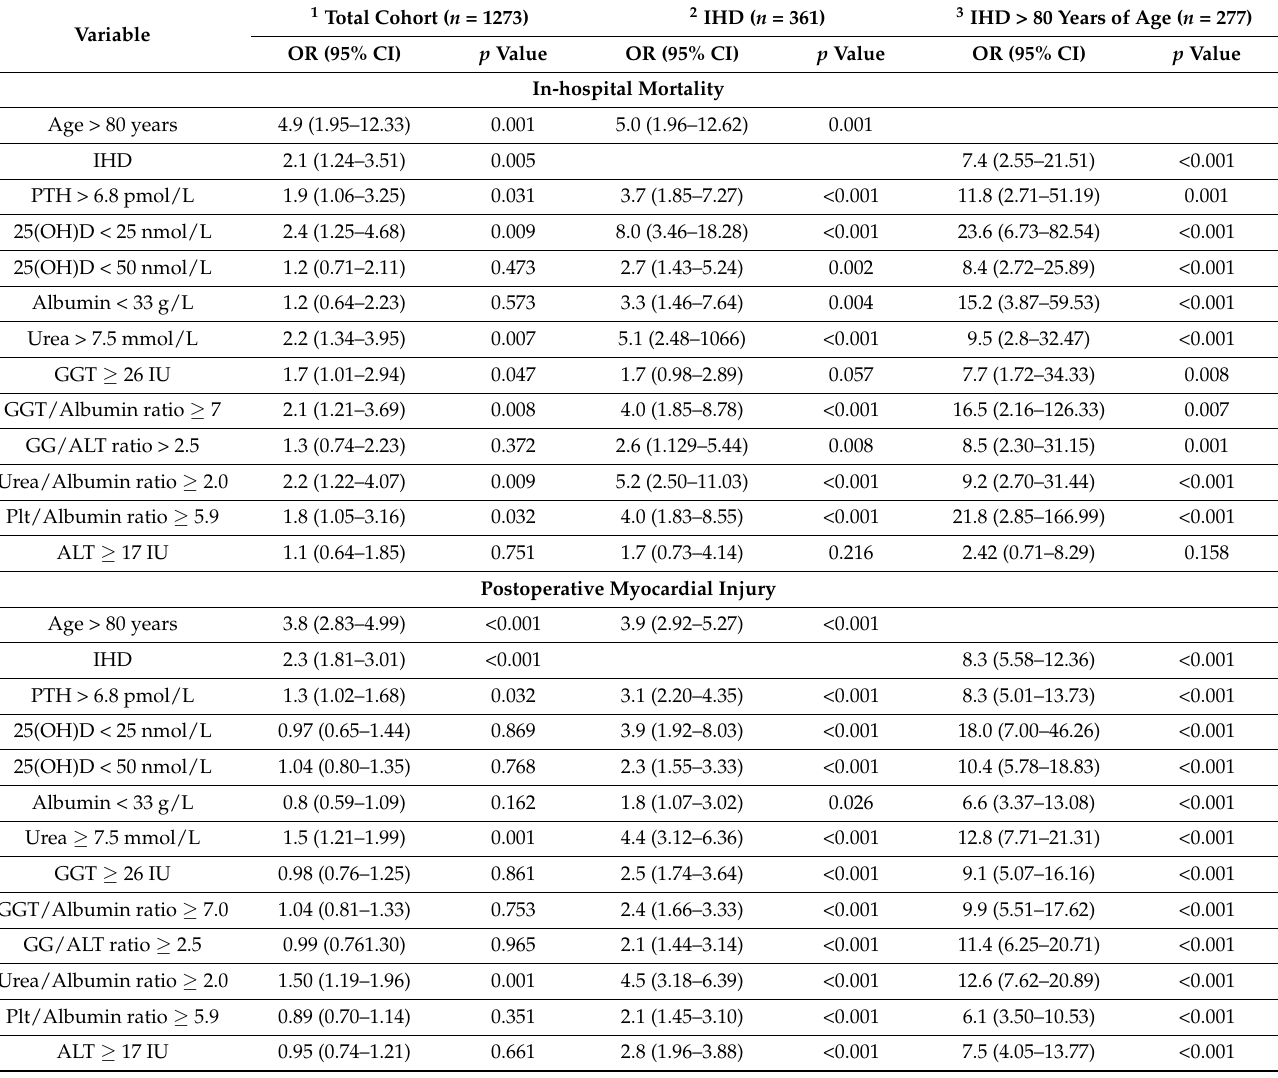
Table 3. Prognostic value of age, presence of IHD and specific biochemical characteristics at admission for predicting in-hospital death and postoperative myocardial